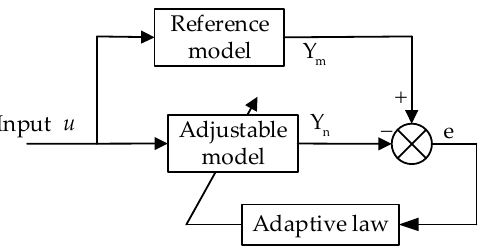
Figure 1. Principle diagram of MRAS structure.